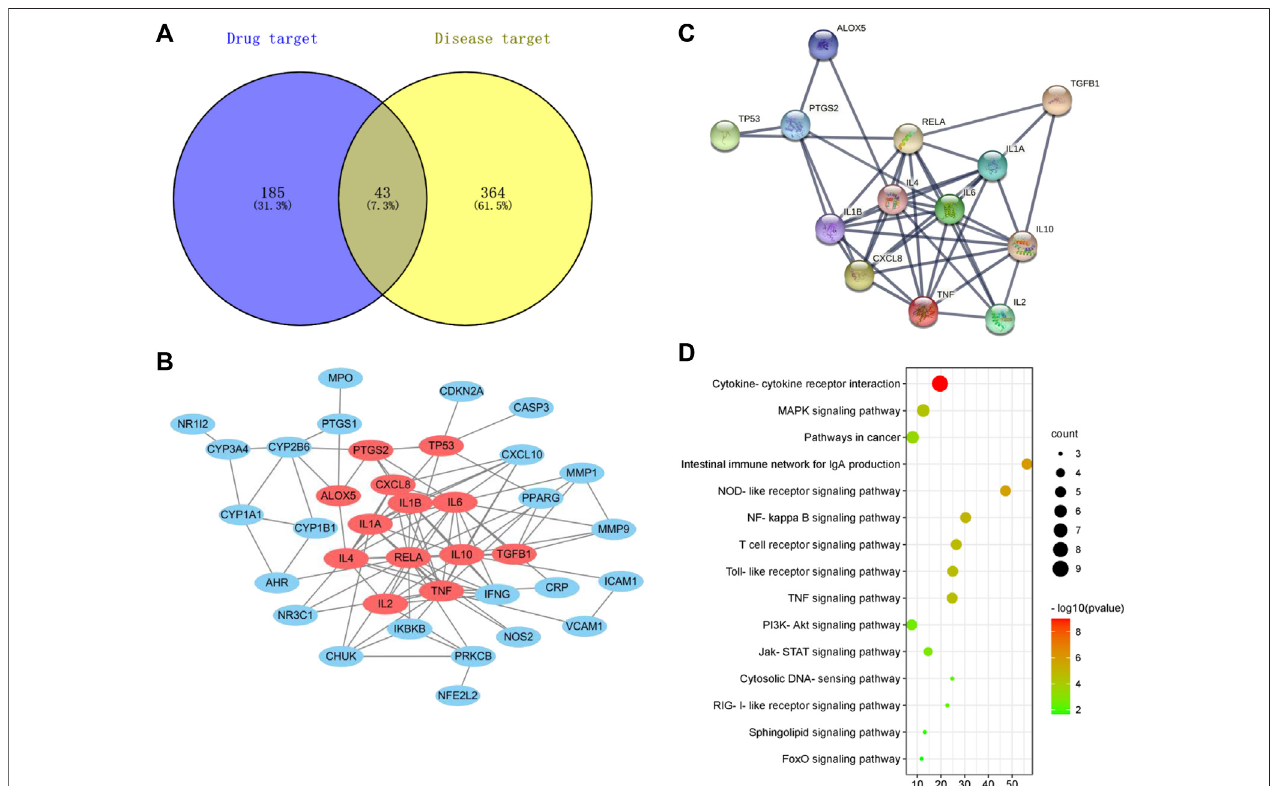
FIGURE 8 | Network pharmacology prediction of WMW treatment for DSS-induced colitis . (A) The intersection of WMW targets and disease targets. (B) 43 core targetsofWMWactingonDSS-induced colitis . (C) TheresultofPPIanalysisforpotentialtargetsofWMW. (D) TheresultofKEGGenrichmentanalysisforthepotentials pathway of